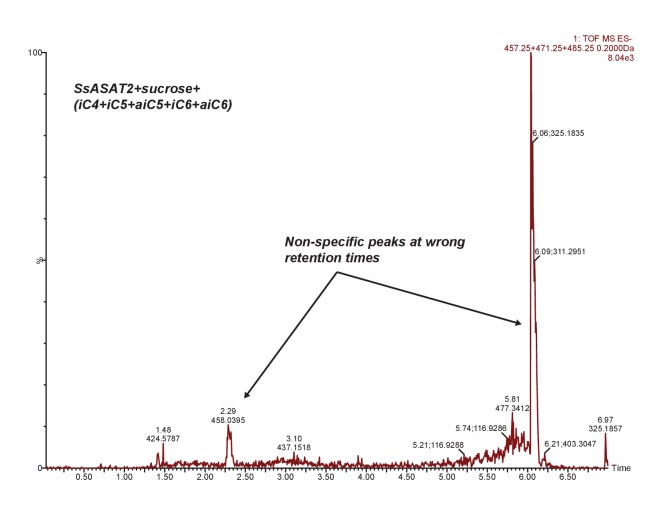
SsASAT2 does not acylate sucrose.Extracted ion chromatogram of masses corresponding to S1:4(4), S1:5(5) and S1:6(6). No peaks corresponding to these products are seen. Additional reactions with individual CoAs -- aiC6 CoA and nC12 CoA -- are shown in Figure 7—figure supplement 1.